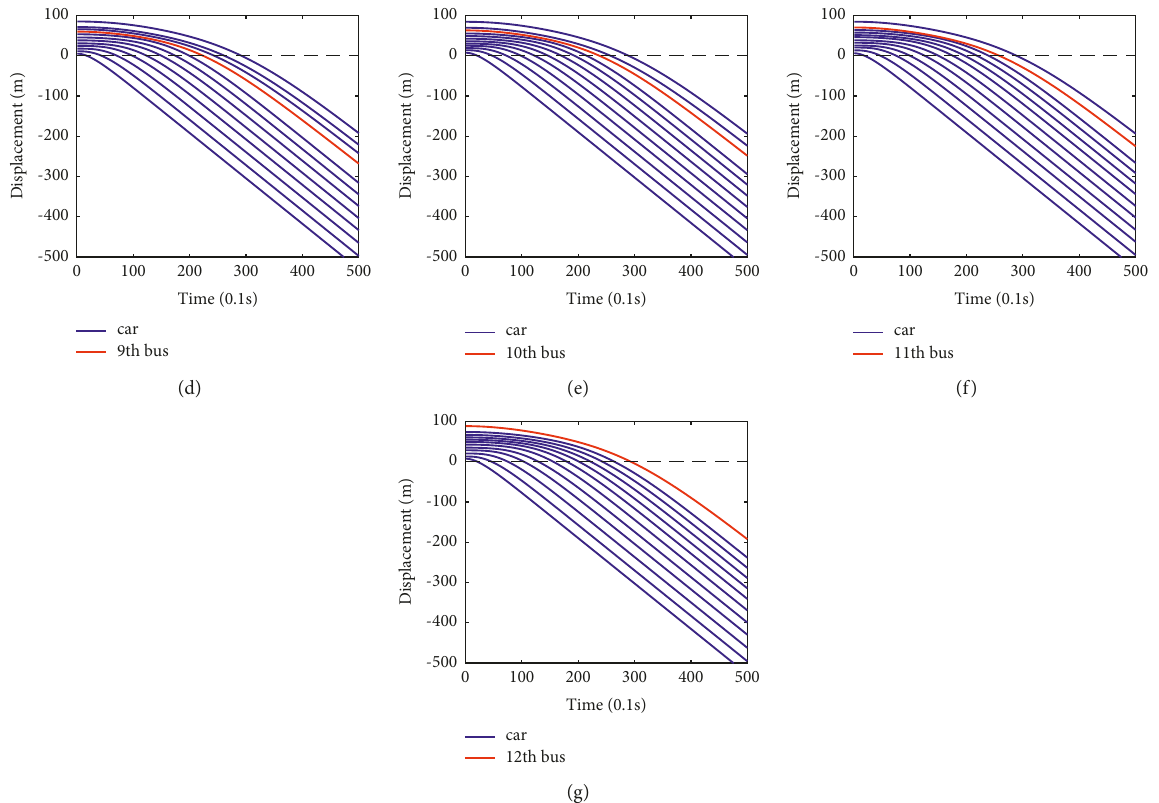
Figure 18: The numerical simulation diagram in 0–10% heavy vehicles scenario. (a) The bus at the 6th position. (b) The bus at the 7th position. (c) The bus at the 8th position. (d) The bus at the 9th position. (e) The bus at the 10th position. (f) The bus at the 11th position. (g) The bus at the 12th position.